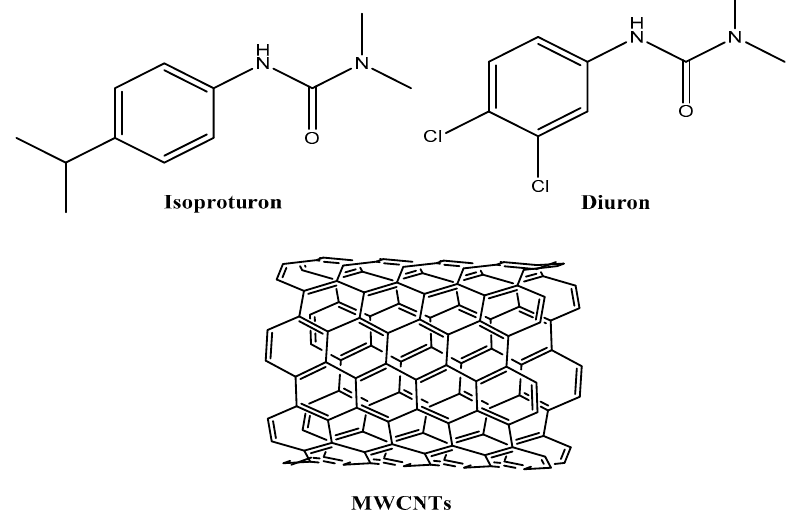
Figure 1. Chemical structure of the studied compounds.